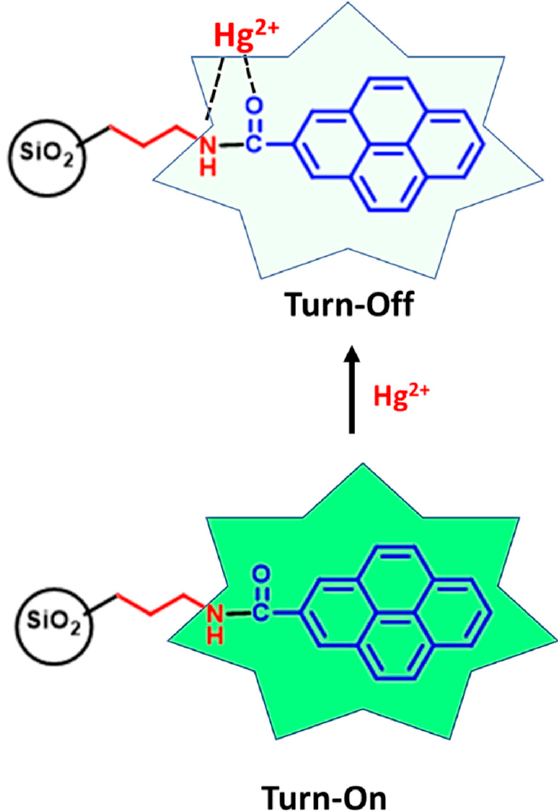
Figure 7. A possible mechanism for interaction of Hg 2+ ions with Pyr-NH@SiO 2 NPs. The developed sensor was also tested for recognition of Hg 2+ ions present in a real seawater sample. Figure 8a demonstrates that the fluorescence intensity of Pyr-NH@SiO 2 NPs (20 ppm) quenches ~60% with the addition of spiked Hg 2+ ions (20 ppm). This indicates the effective recognition of Hg 2+ ions in the presence of competitive metal cations in the seawater sample. In order to investigate the selectivity of as-synthesized Pyr-NH@SiO 2 NPs sensors, the major cations of seawater, such as Na + , K + , Ca 2+ , Mg 2+ , Ba 2+ , and Ag + ions, were individually analyzed with Pyr-NH@SiO 2 NPs. It is estimated that the most suitable binding mode of Hg 2+ ions with pyrene is 1:1 stoichiometry. Therefore, the optimum concentration for each metal cation was kept at 20 ppm against Pyr-NH@SiO 2 NPs (20 ppm) and fluorescence intensity was measured at 398 nm. Figure 8b demonstrates that there is a slight change in the fluorescence intensity of Pyr-NH@SiO 2 NPs upon the addition of each competitive cation. However, there is a drastic quenching (~60%) of fluorescence intensity upon Hg 2+ addition due to the formation of a stable mercury-pyrene complex, which demonstrates the reliability as well as selectivity of the developed sensor for seawater samples. The developed chemosensor was cross verified with the help of the USEPA modified method 7473 on Nippon MA-3000 direct mercury analyzer. All three concentrations (25, 50, and 100 ppb) of Hg 2+ ions were precisely matched with the mercury concentrations utilized in the Pyr-NH@SiO 2 NPs